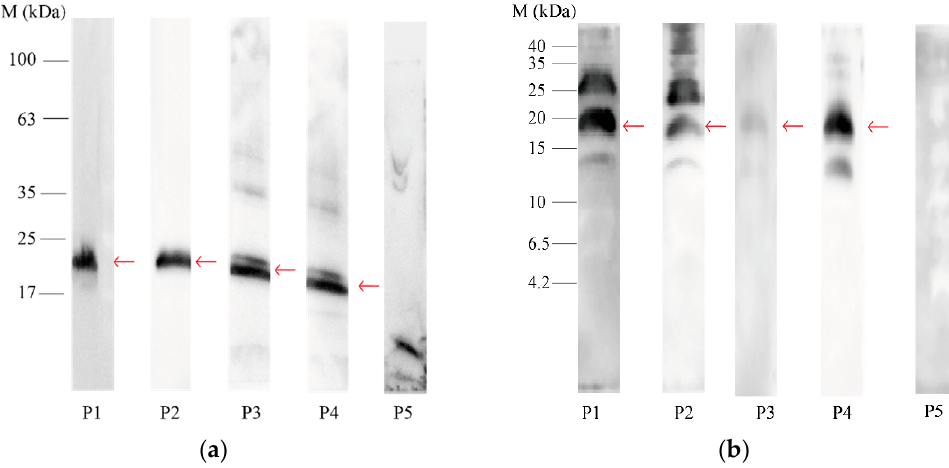
Figure 2. Immunoblot analysis of the serum IgE from five patients with allergy to pitaya (P1~P5) binding to white-fleshed pitaya seeds protein extraction. Approximately 20 kDa of IgE protein bands showing reactivity are marked with red arrows: ( a ) immunoblot analysis after protein separation of white-fleshed pitaya seed extracts on 4~20% Tris–Gly–SDS polyacrylamide gels; ( b ) immunoblot analysis after protein separation of white-fleshed pitaya seed extracts on 16.5% Tris–tricine polyacrylamide gels.